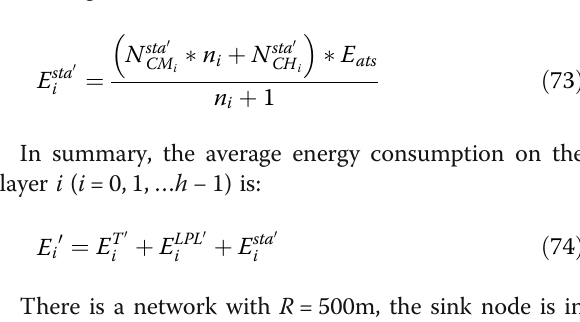
takes different 0